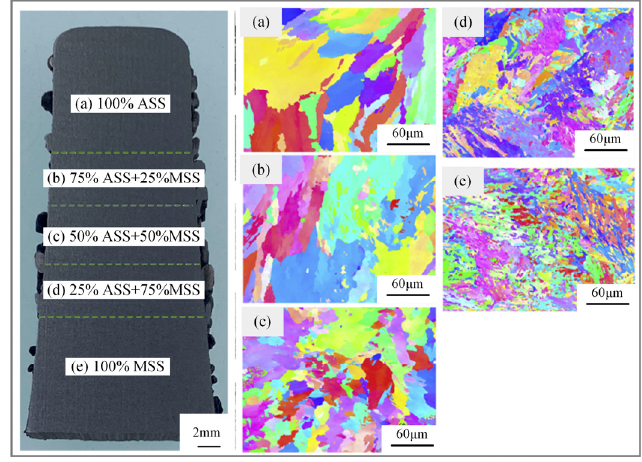
Figure 5. ( a – e ) IPF figures of MSS/ASS FGMs for region with different mass fractions [47].